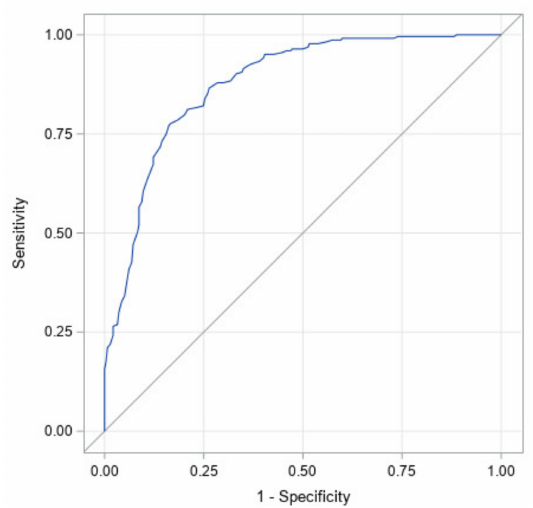
Figure 4. ROC curve for the initial cephalic index only. The area under the curve is 0.88 (statistically significant with p < 0.0001).